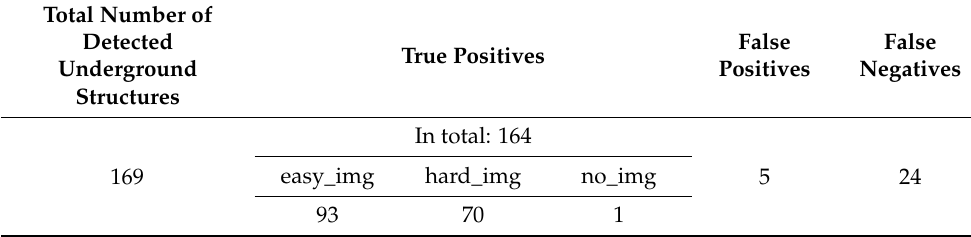
Table 3. Classification of detection results according to the curated reference Table 3. Classi fi cation of detection results according to the curated reference data.